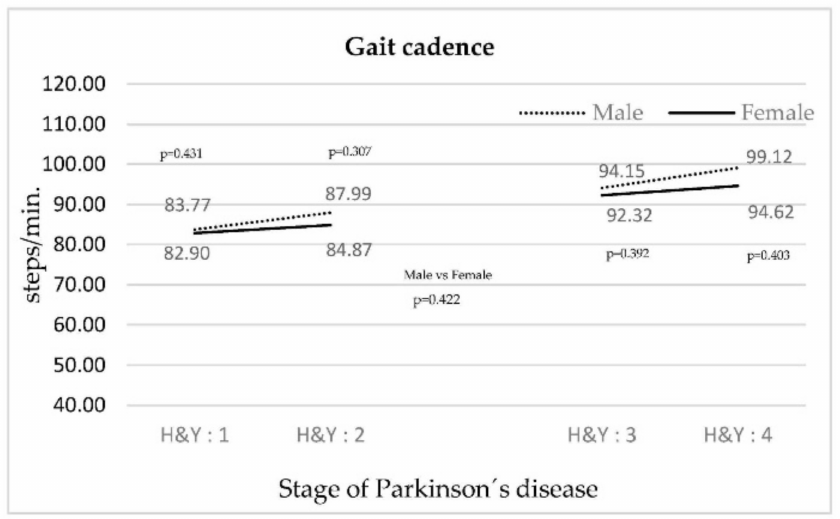
Figure 2. Evolution of gait cadence according to the stage of PD. The behavior of the acceleration and deceleration gradient of the left leg in both stages was similar (Figure 3), but in the right leg there were significant differences in the deceleration gradient in stages H&Y